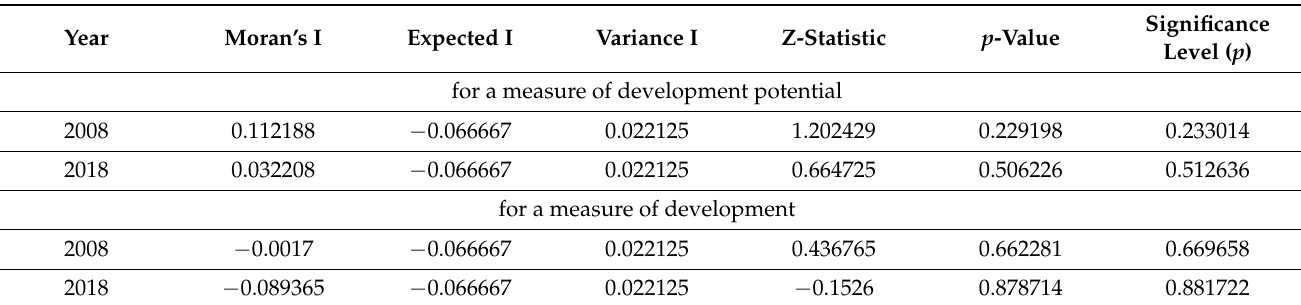
Table 8. Values of Moran’s global statistics in 2008–2018 for the potential of agriculture and development in Poland by voivodship.